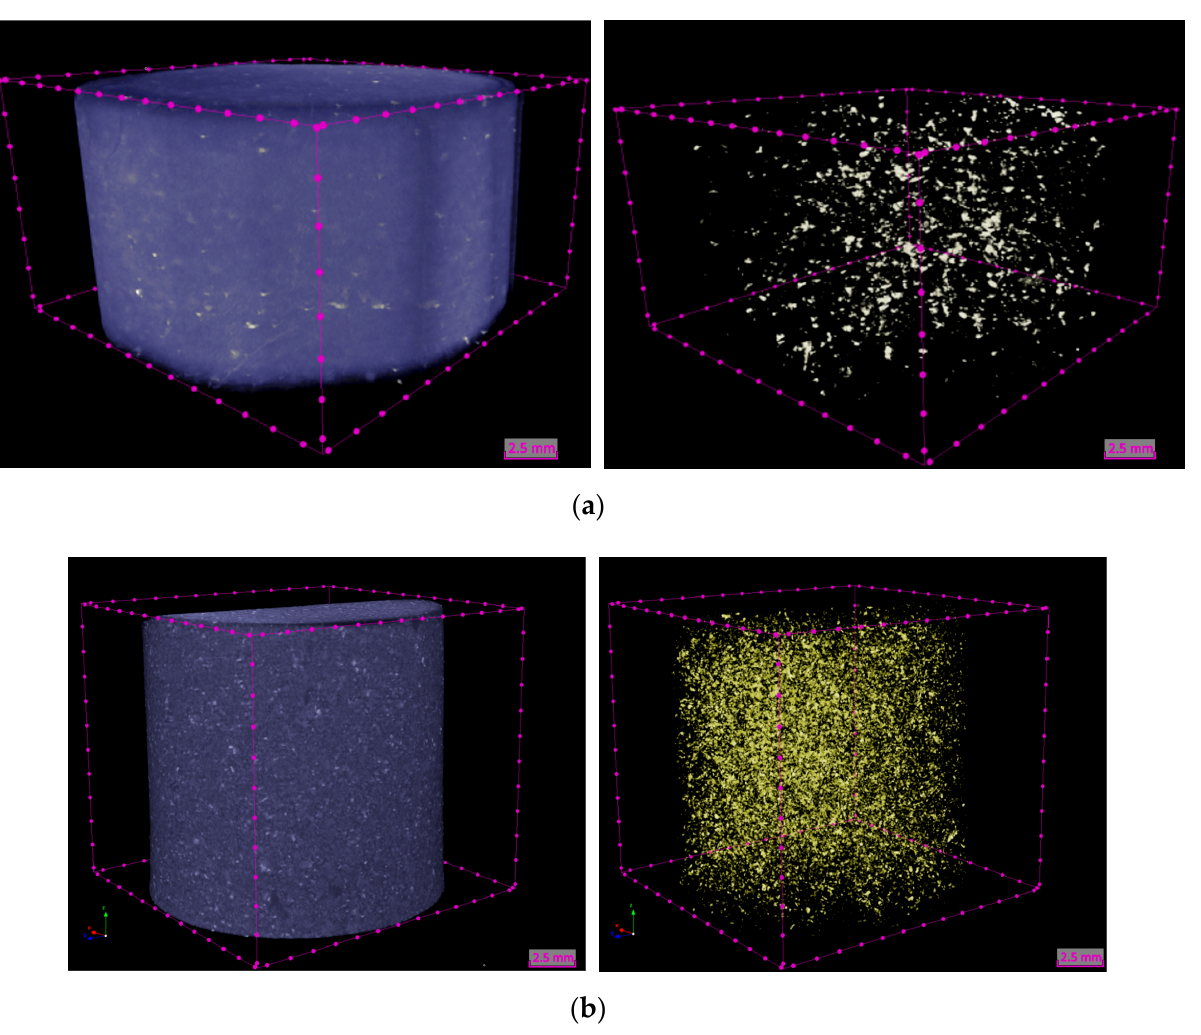
Figure 6. 3D visualization of the sample ( left ) and distribution of ore minerals in the rock volume ( right ): ( а ) BDO; ( b ) CNO. The results of the research of these parameters are presented in Table 5. Table 5. Analysis of morphometric indicators of the sample obtained by X-ray microtomography method. Ore Sample